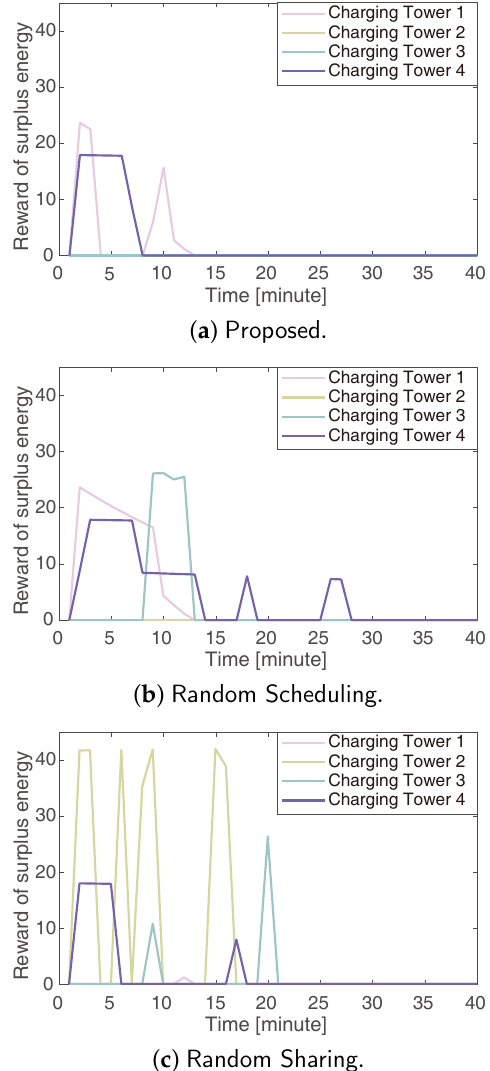
Figure 6. Surplus energy with ( a ) the Proposed algorithm, ( b ) the Random Scheduling algorithm, and ( c ) the Random Sharing